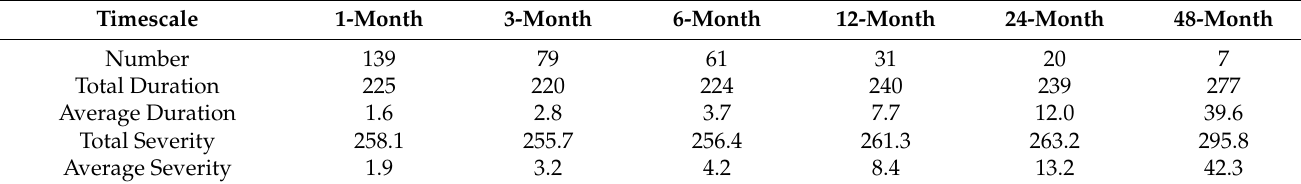
Table 3. Drought characteristics of NWC derived from SPEI at different